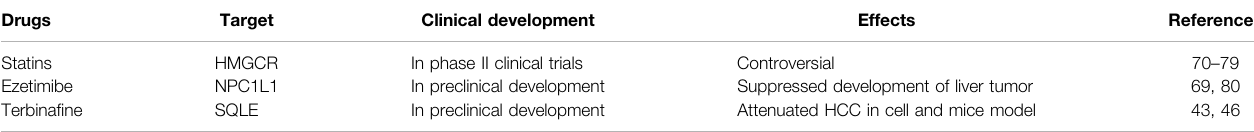
TABLE 1 | New approaches that target cholesterol metabolism in HCC.